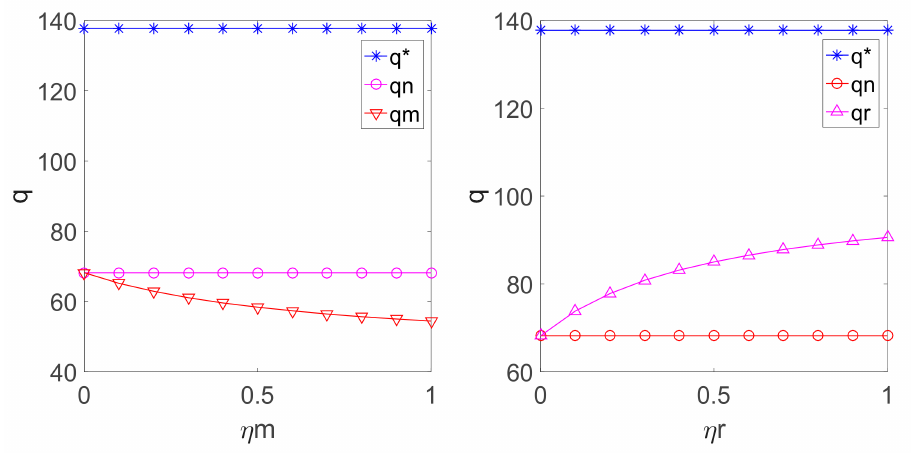
Figure 5. Relationship among η m , η r and q .